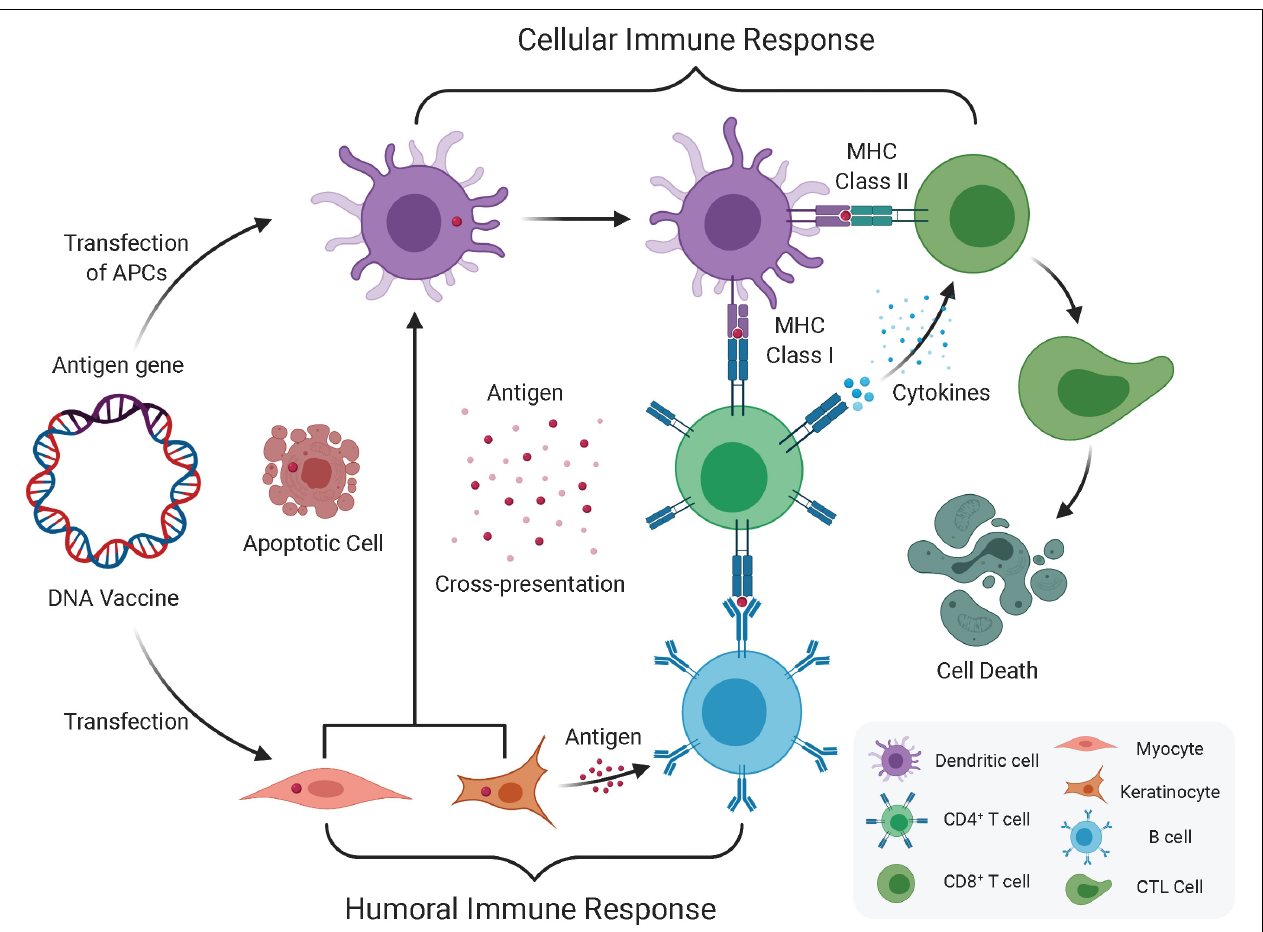
FIGURE 1 | Humoral and cellular immune response induced by DNA vaccination. The immune response induced by DNA vaccine encoded antigen mainly via direct transfection of APC (DC) and Keratinocyte or Myocyte. One route that DNA vaccines transfected into keratinocytes or myocytes expresses antigen genes through exosomes or apoptotic bodies and releases derived peptides and proteins, which are then endocytosed by dendritic cells (DC), and then preferentially presents antigens to CD4 + T cells through MHC II, which produces cellular immune system. The other route that direct transfection of APC leads to endogenous antigen gene expression, which in turn is expressed in parallel by MHC I and MHC II, and simultaneously elicits CD8 + and CD4 + T cell responses. In addition to this cellular immune response, once the B cell receptor recognizes protein antigens from somatic cells (i.e., keratinocytes or myocytes) and obtains the help of pre-activated antigen-specific CD4 + T cells, which can induce a humoral immune